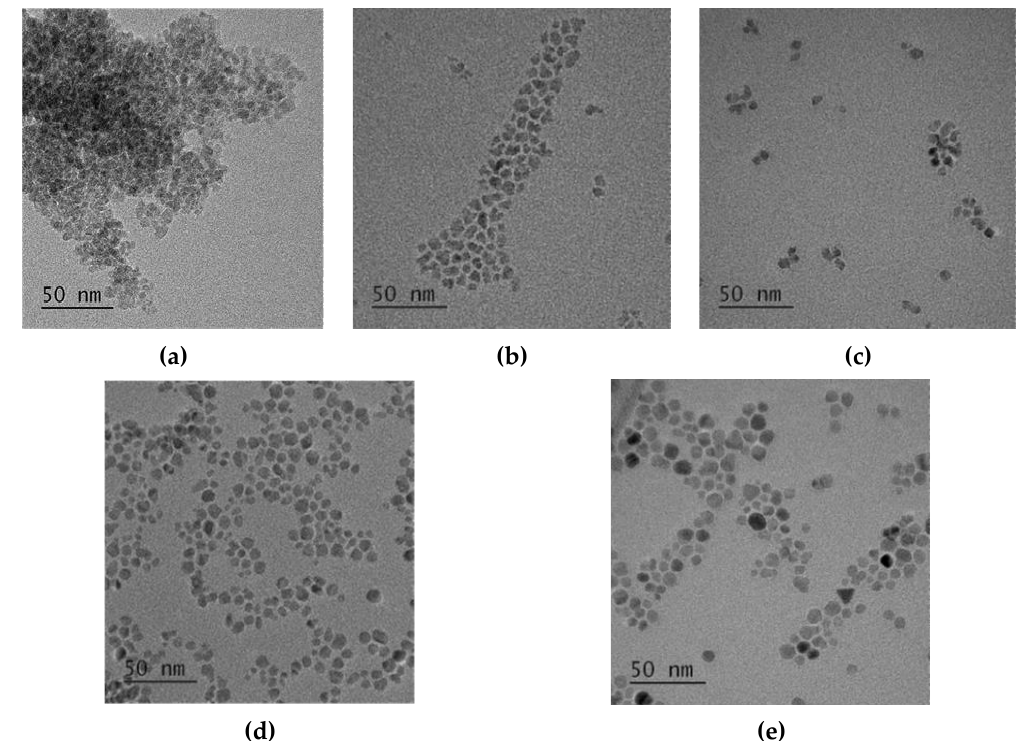
Figure 6. TEM images of cobalt ferrite nanoparticles synthesized at 16 h in the presence of 1 M oleic acid for different reaction temperatures 120 °C ( a ), 140 °C ( b ), 160 °C ( c ), 180 °C ( d ), 200 °C ( e ).